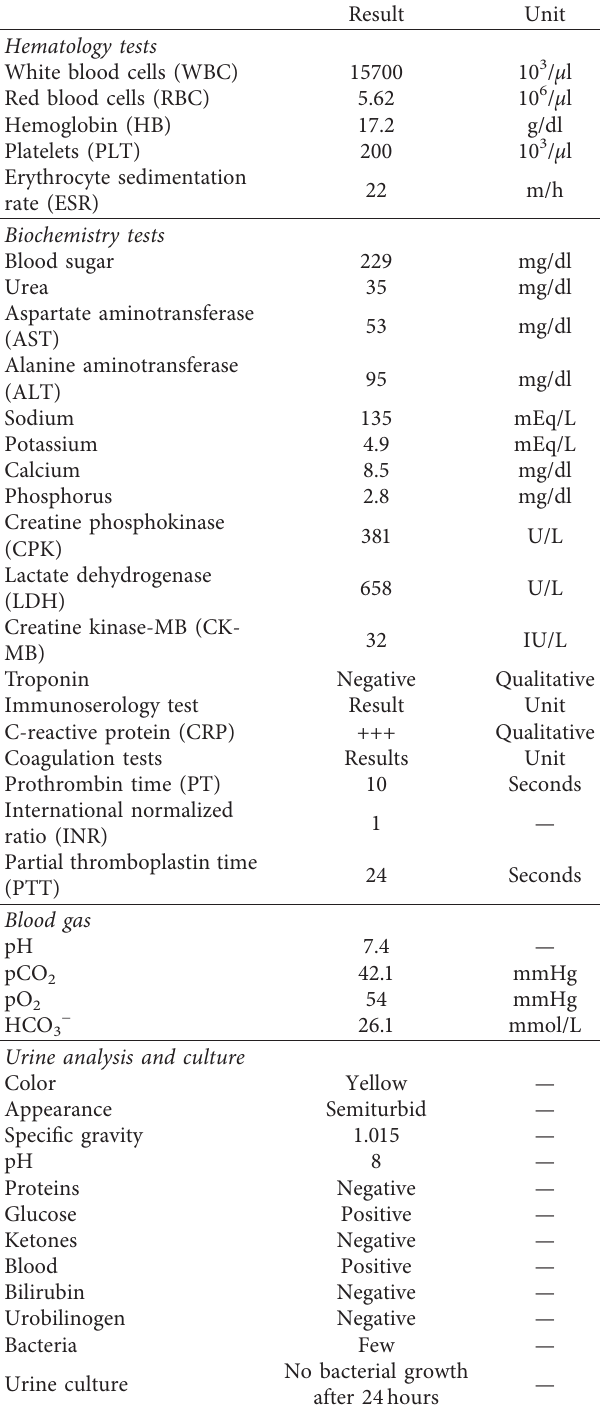
Table 1: Initial laboratory